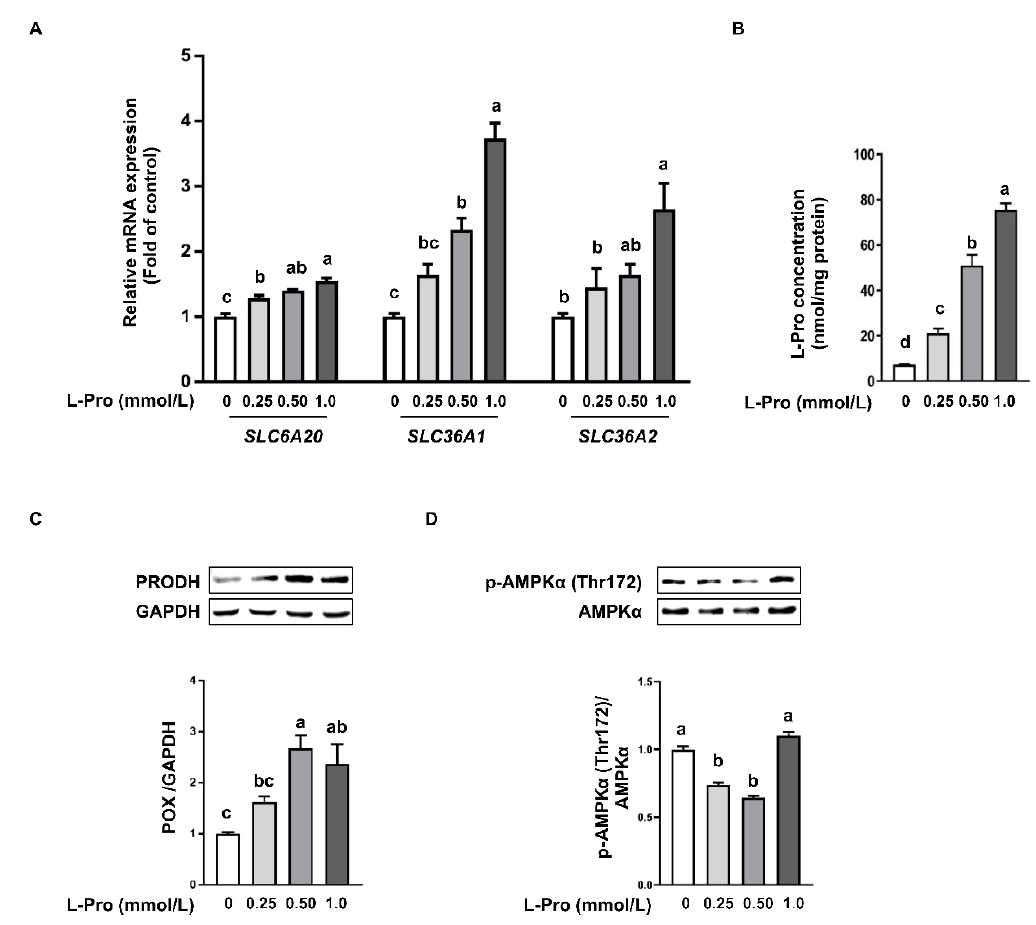
Figure 3. Effect of proline on proline transport and metabolism in pTr2 cells. ( A ) mRNA expression for proline transporters. ( B ) Proline concentration in pTr2 cells. ( C ) The protein abundance of PRODH in pTr2 cells. ( D ) The protein abundance of total and p-AMPK in pTr2 cells. Data are expressed as the percentage of control group. Values are means ± SEMs, n = 3. Means at a time point without a common letter differ, p < 0.05. GAPDH, glyceraldehyde-3-phosphate dehydrogenase; PRODH, proline dehydrogenase; pTr2, porcine trophectoderm cells 2; SLC, solute carrier family.